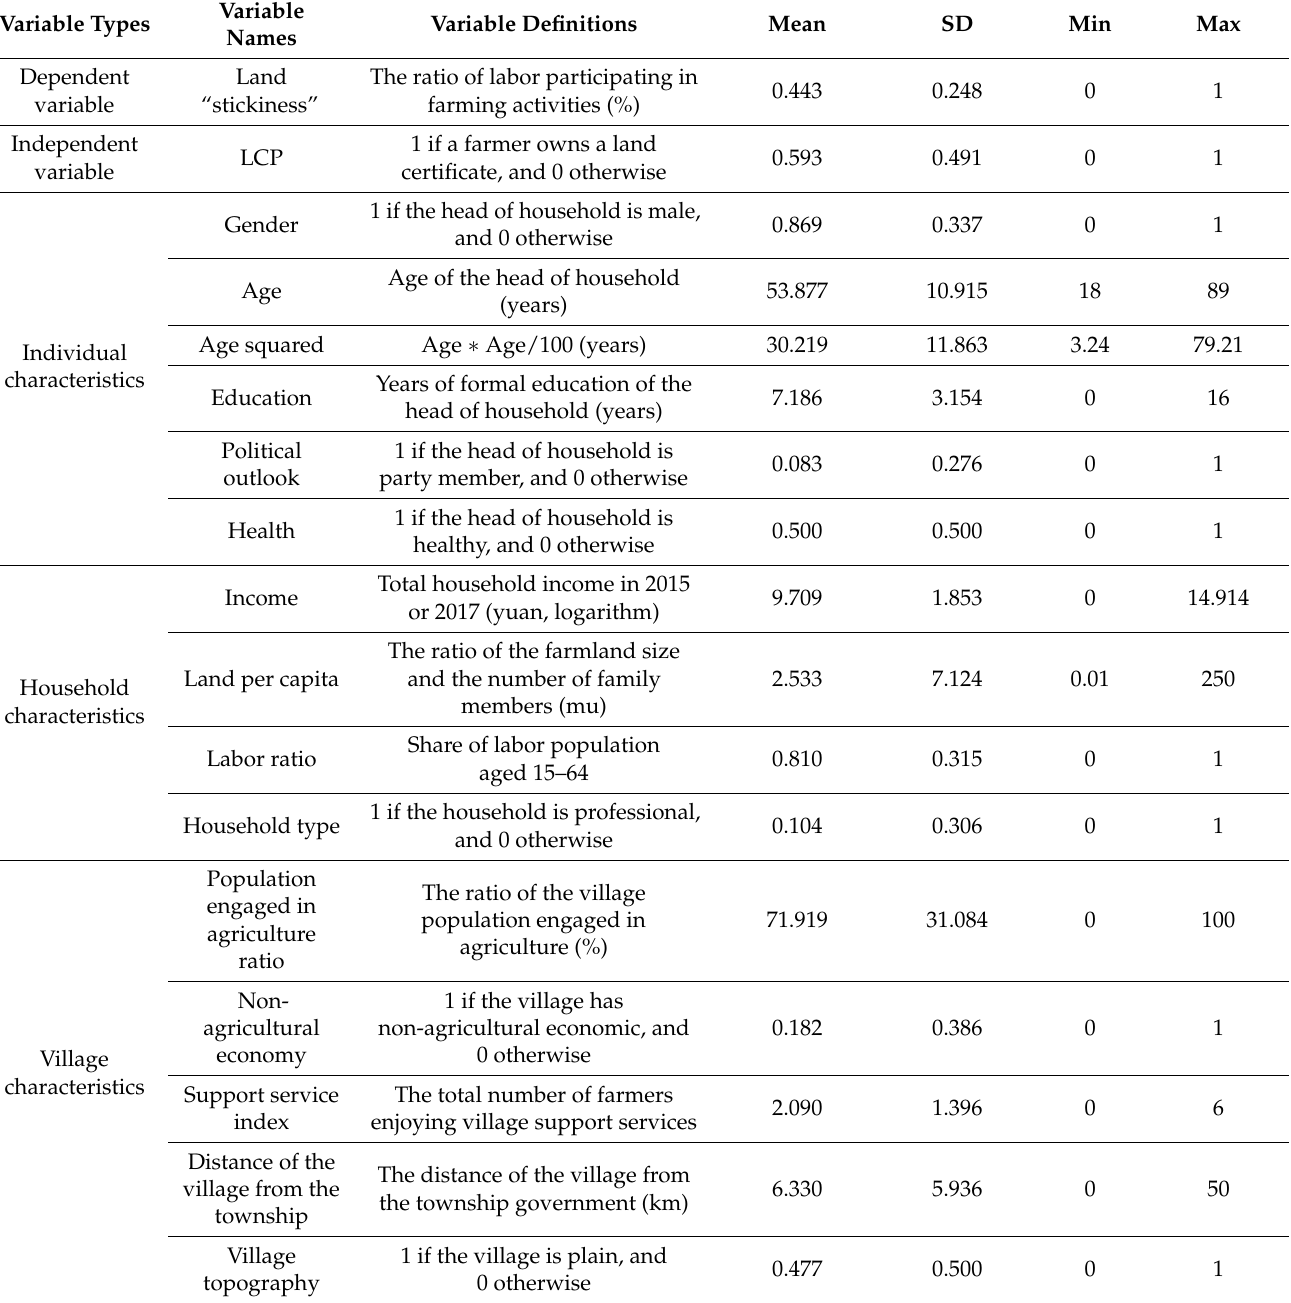
Table 1. Definitions and Descriptions of